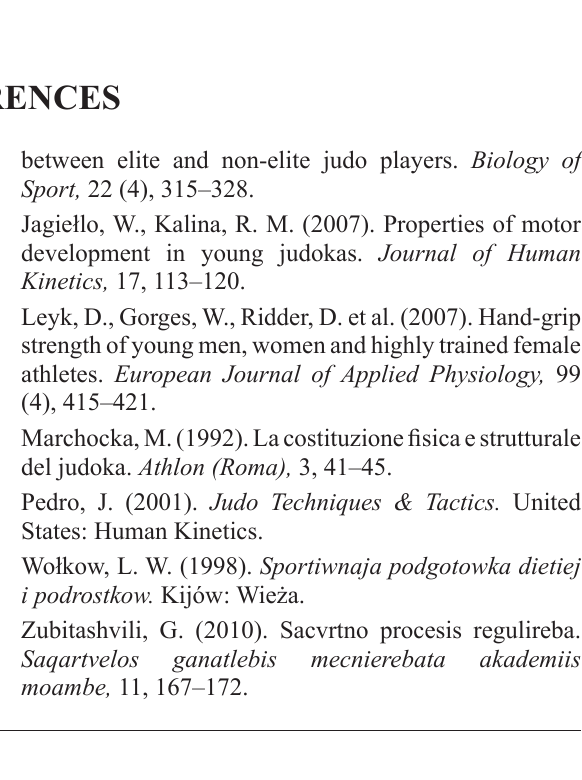
Note. ** – correlation is significant at the 0.01 level